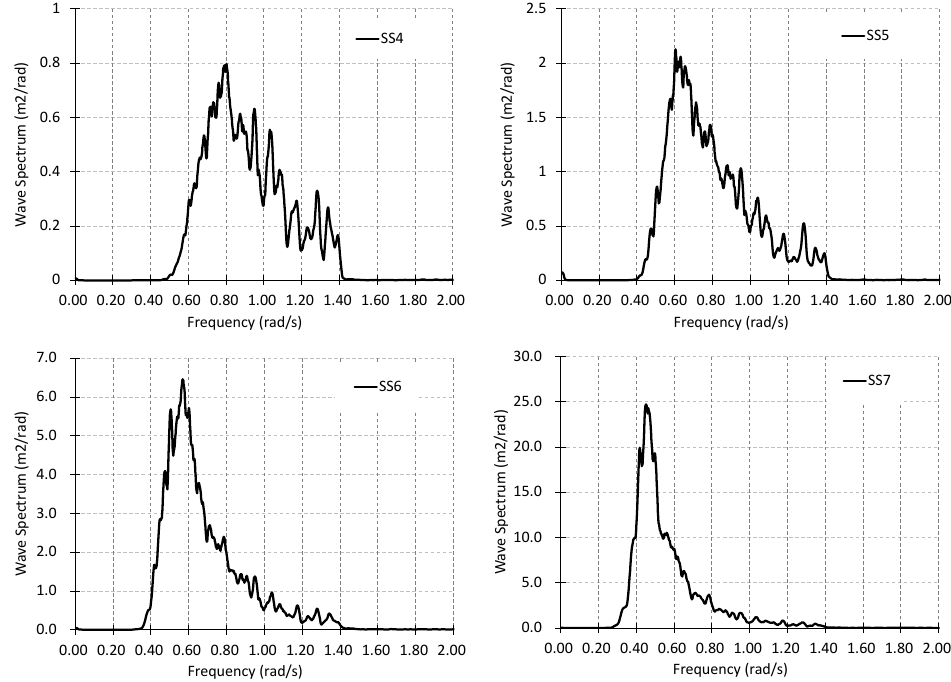
Figure 8. Four irregular wave spectrums generated by the wave maker for model tests (results are presented at a full scale ratio).